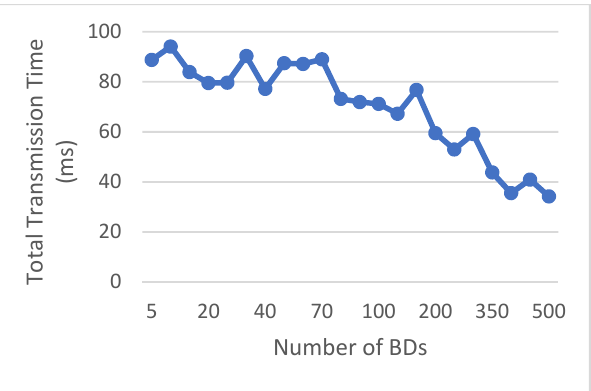
Figure 13. The total transmission time vs. the number of BDs in the LMF model.